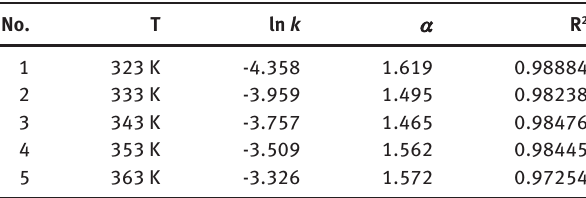
Table 3 The kinetic parameters for the esterification of caprylic acid with methanol over (Tshx)(HSO